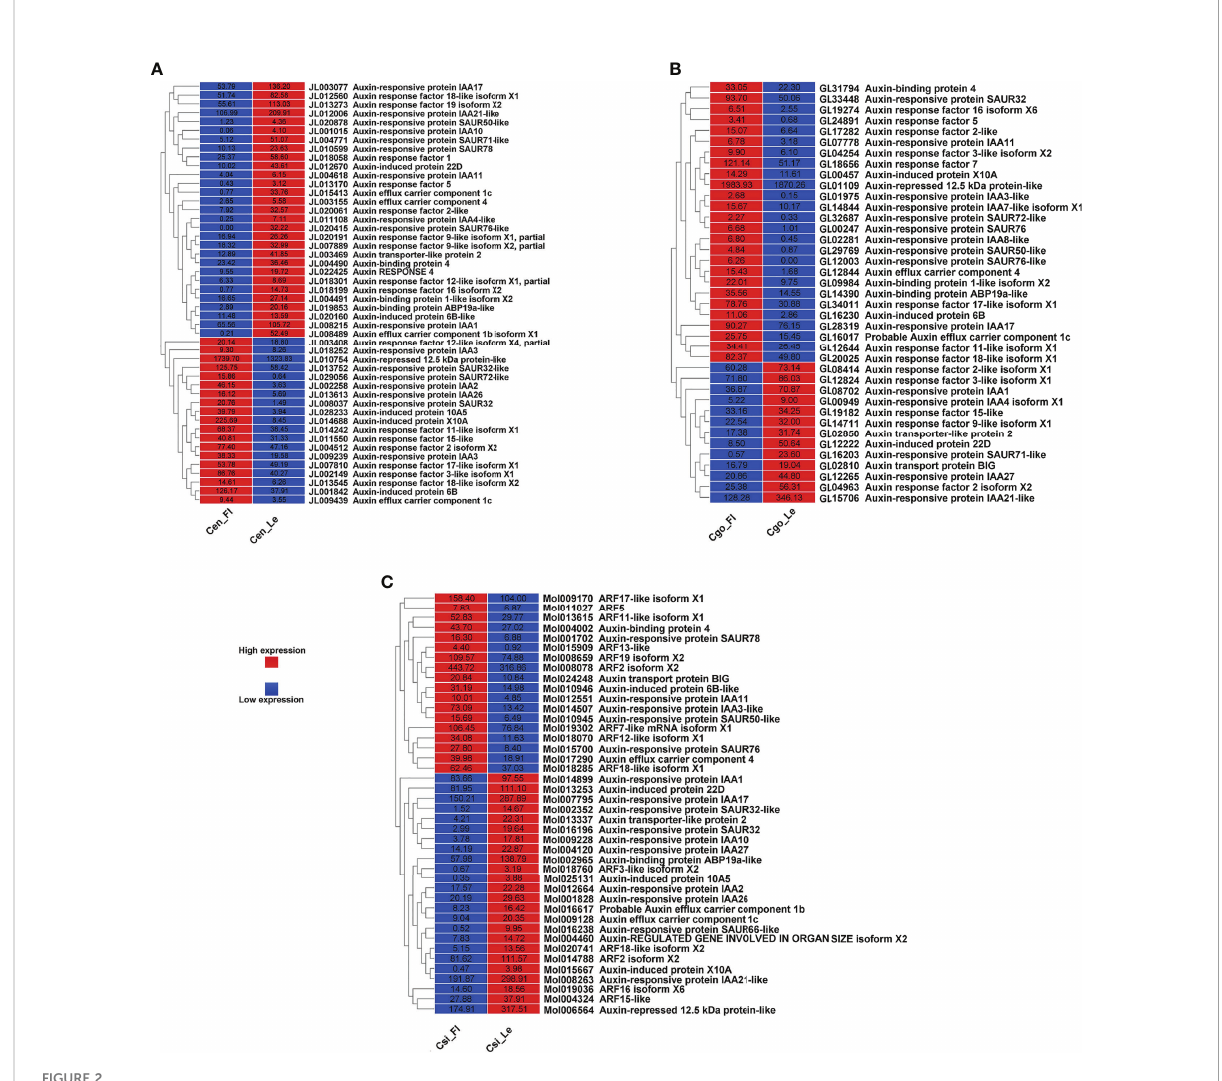
FIGURE 2 Auxin pathway genes for C ensifolium (A) , C goeringii (B) and C sinense (C)